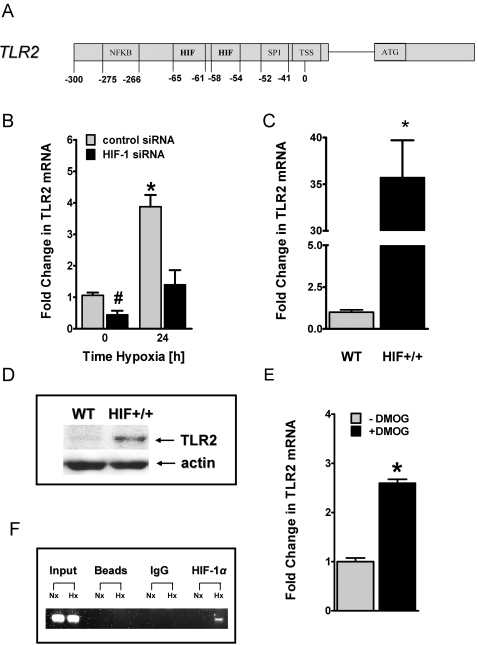
Influence of hypoxia inducible factor (HIF)-1α on TLR2 expression during hypoxia.
A, Map of TLR2 promoter region showing positions of the putative HIF binding sites and the binding site for NFκB and SP1 relative to the transcription start site (TSS). B, Stable transfected HMEC-1 monolayers containing either HIF-1α siRNA or control-siRNA were exposed to normoxia or hypoxia for indicated time points. Total RNA was isolated, and 1 µg of RNA was transcribed into first strand cDNA. Relative expressional levels of TLR2 transcript were compared to normoxic controls by real-time RT-PCR. Data were calculated relative to internal control gene (ß-actin), and are expressed as fold change over normoxia±SEM, *, significant differences from normoxia and control cells (p<0.05). Results are derived from three different experiments in each condition. C, Total RNA of normoxic monolayers of either wildtype (WT) or oxygen-stable HIF-1α expressing (HIF+/+) HMEC-1 cells was isolated and real-time RT-PCR was performed as described above. *, significant differences from wildtype cells (p<0.001). D, Western blot analysis of TLR2 protein of normoxic HMEC-1 wild type (WT) and oxygen-stable HIF-1α expressing (HIF+/+) cells. The same blot was probed for ß-actin expression as a control for protein loading. E, HMEC-1 monolayers were treated with 1mM of dimethyloxalylglycine (DMOG), following measurement of TLR2 transcript levels by real-time RT-PCR as described above. *, significant differences from untreated cells (p<0.001). F, ChIP assay was utilized to examine HIF-1α binding to the TLR2 promoter in normoxic and hypoxic HMEC-1 cells. Reaction controls included samples precipitated with protein G sepharose beads alone (beads), immunoprecipitations using a nonspecific igG monoclonal antibody (IgG) and PCR performed using HMEC-1 DNA (input). An example of three experiments is shown.